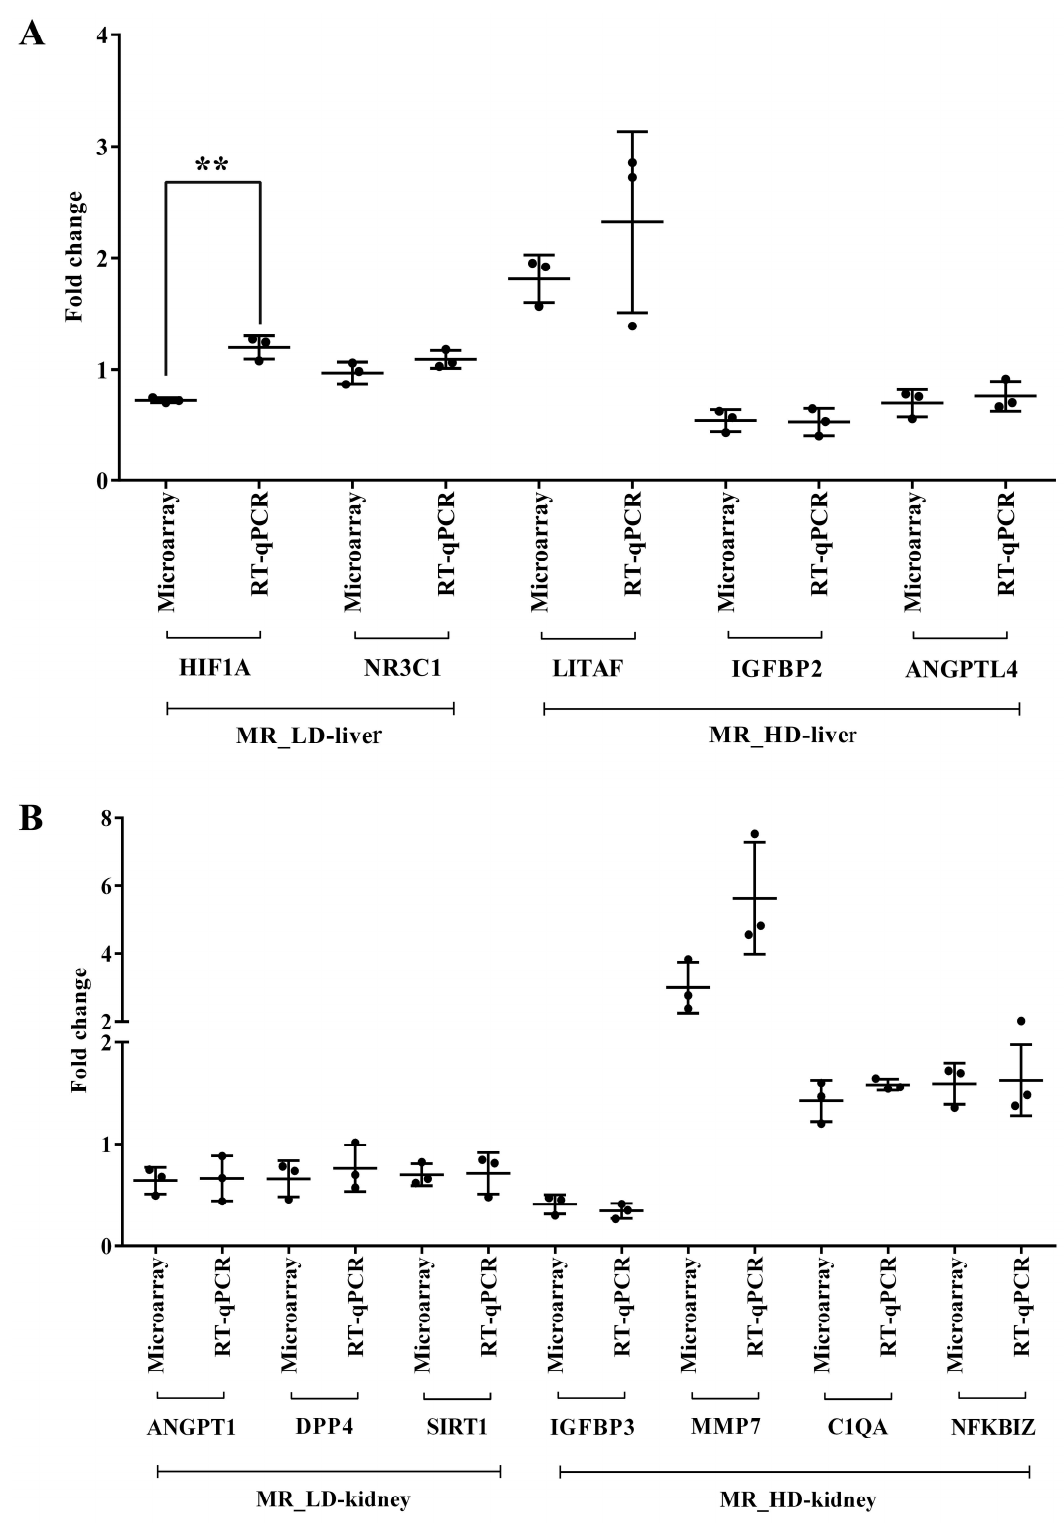
Figure 19. Experimental validation of master regulators by quantitative real-time PCR. Panel A : Ex- pression of hepatic master regulator genes after low- and high-dose diclofenac treatment. Panel B : Expression of master regulatory genes in kidney after low- and high-dose diclofenac treatment. The y-axis indicates the individual fold changes in treated animals (diclofenac-treated vs. controls). Data are Fold change ± SD. ** p < 0.01. MR = master regulator, LD = low-dose, HD =